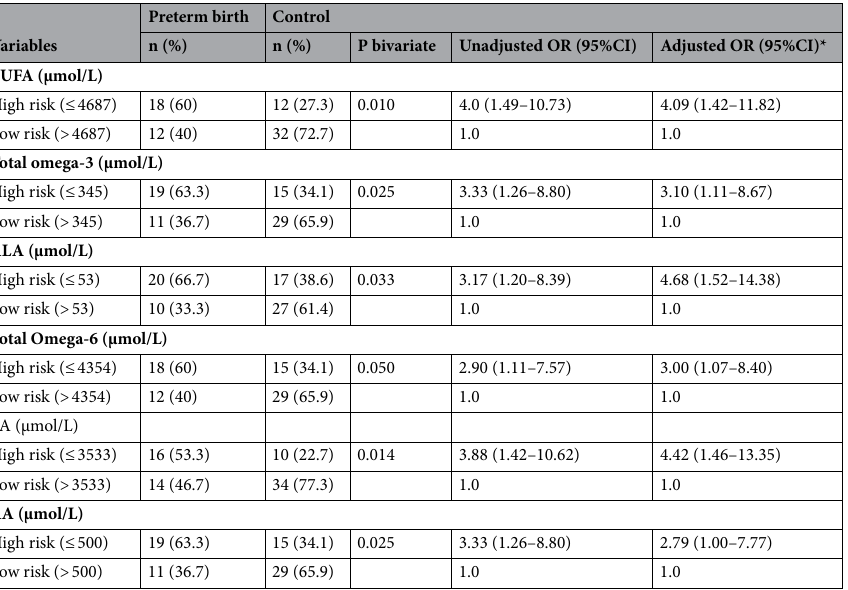
Table 6. LCPUFA parameters showing the risk of preterm birth. *Adjusted for covariates: Maternal age and Maternal pre-pregnancy BMI. 1.0: Reference